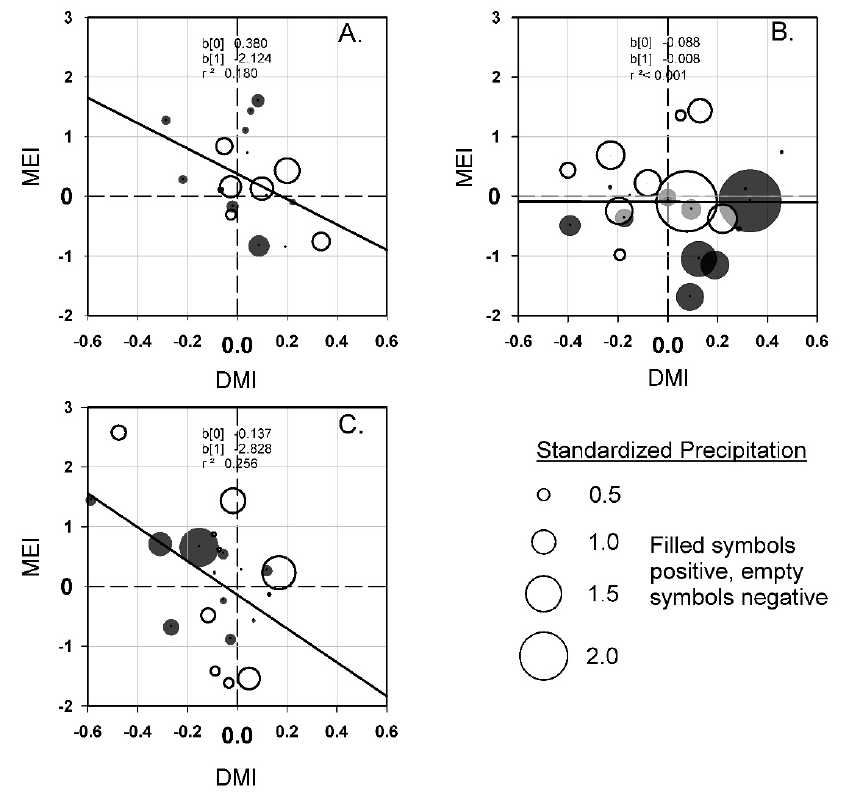
Figure 9. Lag zero cross correlations between annual DMI and MEI 1871–2015 viewed through a 21-year window. Confidence bounds (95%) around estimated coefficients shown for reference.